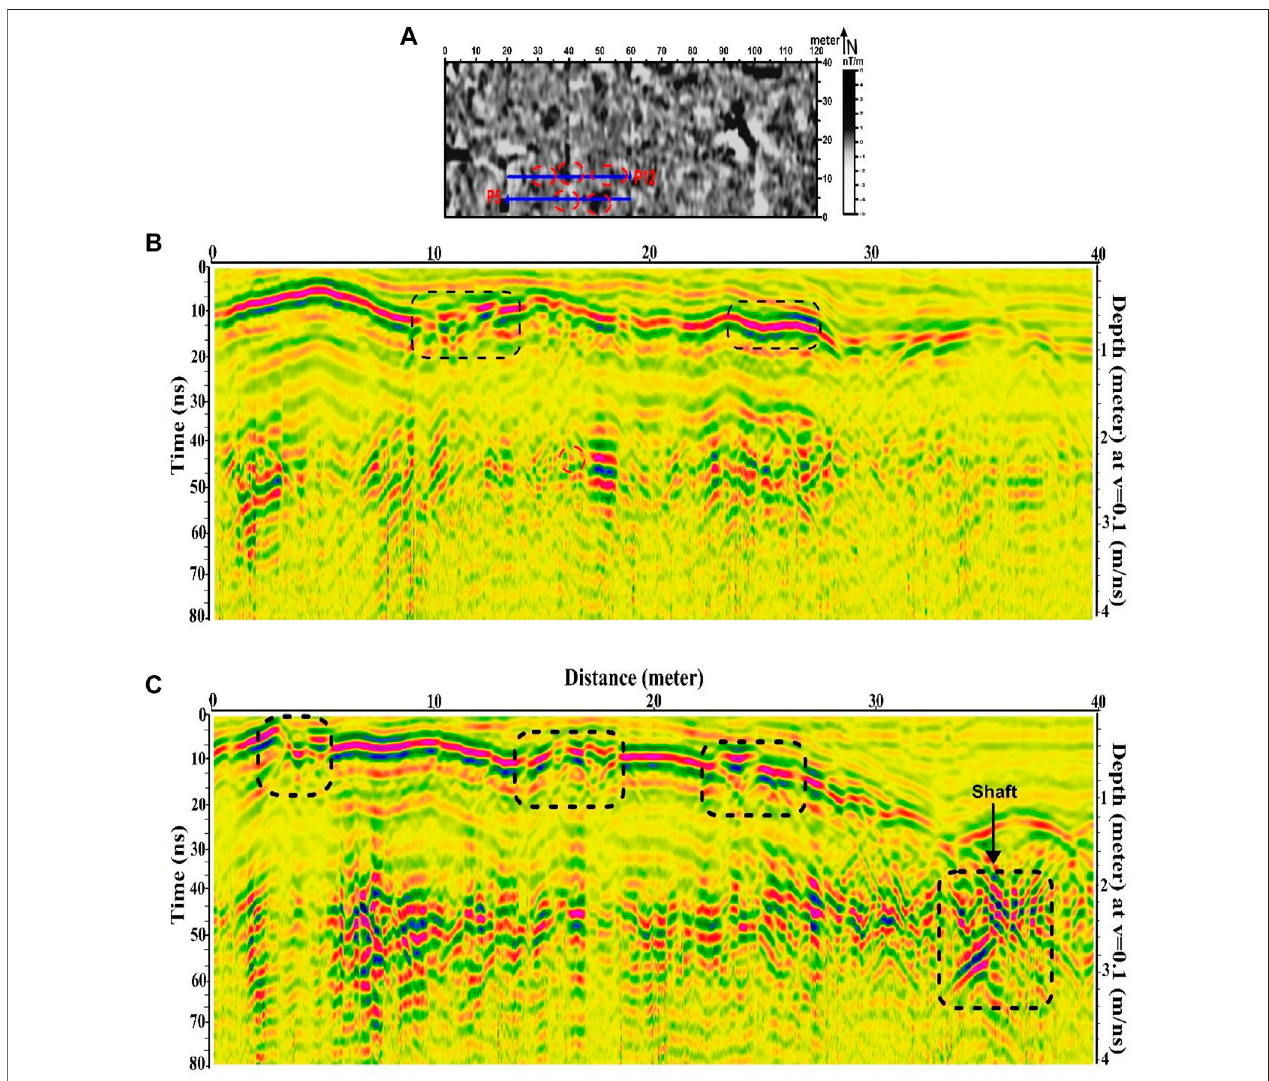
FIGURE 6 | (A) The location of the GPR pro fi les P5 and P12 at site C. (B) GPR display of pro fi le P5. (C) GPR display of pro fi le P12.